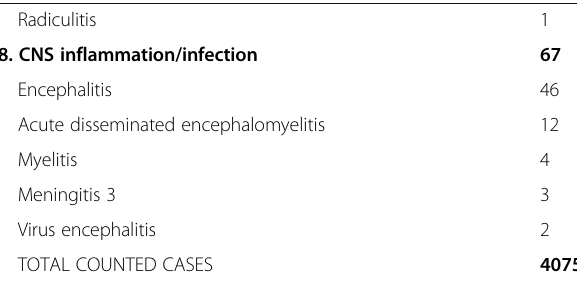
Table 1 Overview of neurologic manifestations in COVID-19 from identified reports